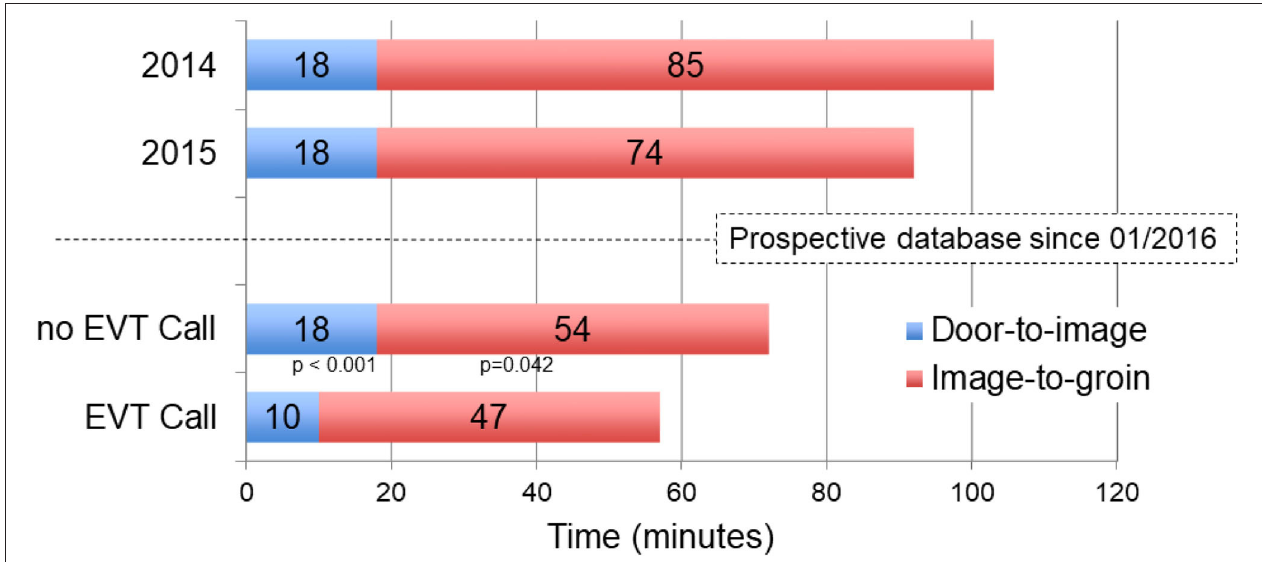
FIGURE 3 | Comparison of median Door-to-image and Image-to-groin times in 2014 and 2015 and before and after implementation of EVT-call.